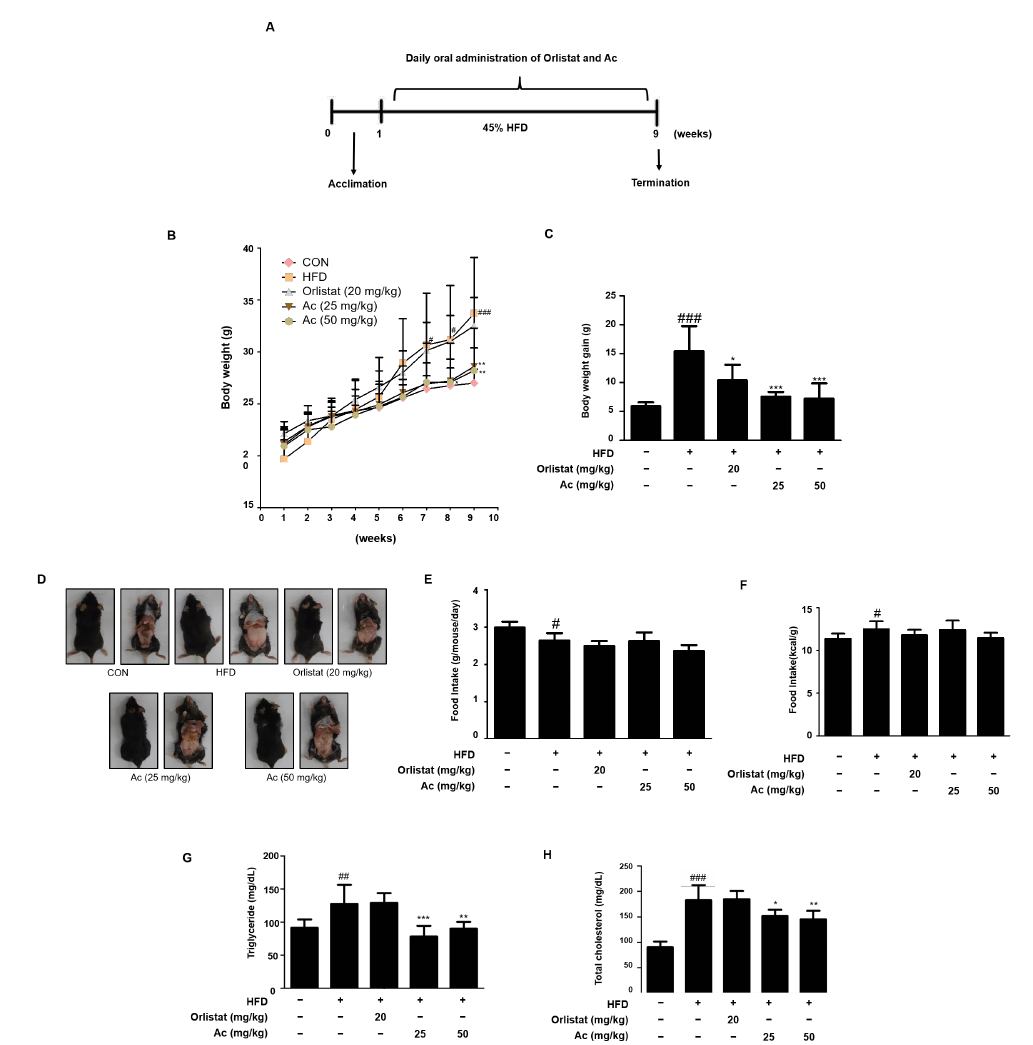
Figure 1. Effect of Ac on body weight, food intake, and TG and TC levels in HFD-induced obese mice. ( A ) A flow chart showing the experimental procedure. ( B ) Body weight. ( C ) Body weight gain. ( D ) Abdominal fat content. ( E , F ) Food intake. The levels of serum ( G ) TG and ( H ) TC. Data are expressed as the mean ± SD # p < 0.05, ## p < 0.01, and ### p < 0.001 vs. chow diet-fed group; * p < 0.05, ** p < 0.01, and *** p < 0.001 vs. only HFD-fed